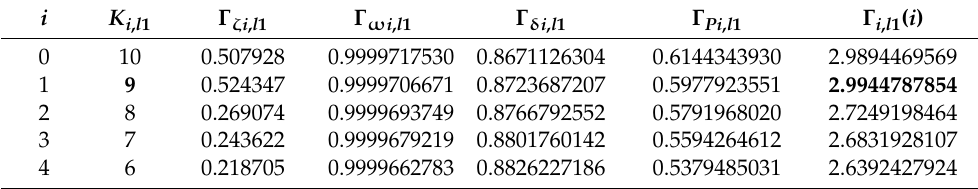
Table 10. Weight functions for PSS parameters T = 0.5 s, K i,um = 10 – 14, m = 1 ( upper cluster 1 ); t = 150 ms.